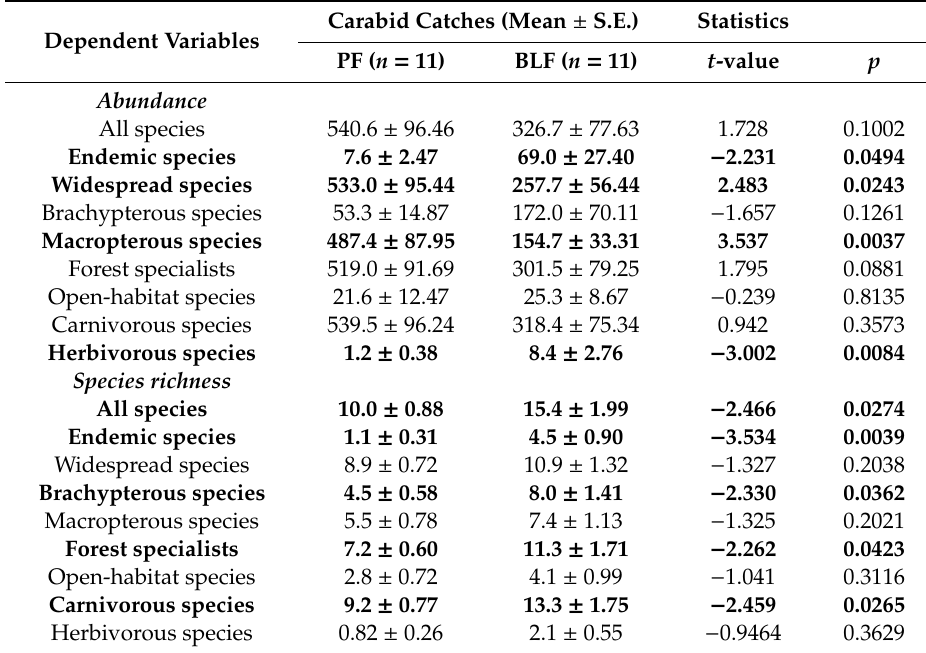
Figure 2. Individual-based rarefaction curves for ground-beetle catches ( a ) in Pinus densiflora forests (PF) and broad-leaved deciduous forests (BLF), and ( b ) in forest age classes (III, 21–30-years old; IV, 31–40-years old; V, 41–50-years old). Data points indicate average species numbers computed for the given number of individuals. Table 2. Comparison of carabid catches (abundance and species richness) between Pinus densiflora forests (PF) and broad-leaved deciduous forests (BLF). Bold characters indicate statistical di ff erence of abundance or species richness of carabid beetles between BLF and PF ( p <